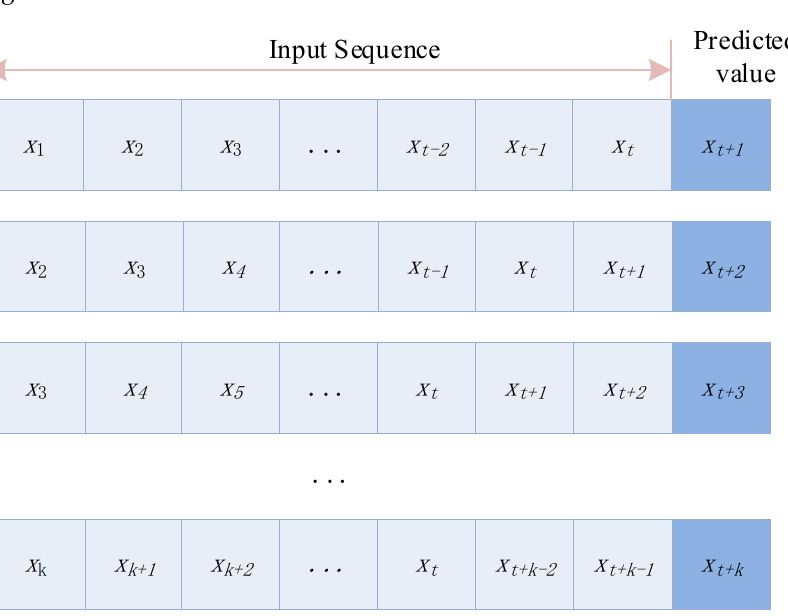
Figure 3. Rolling forecast diagram.